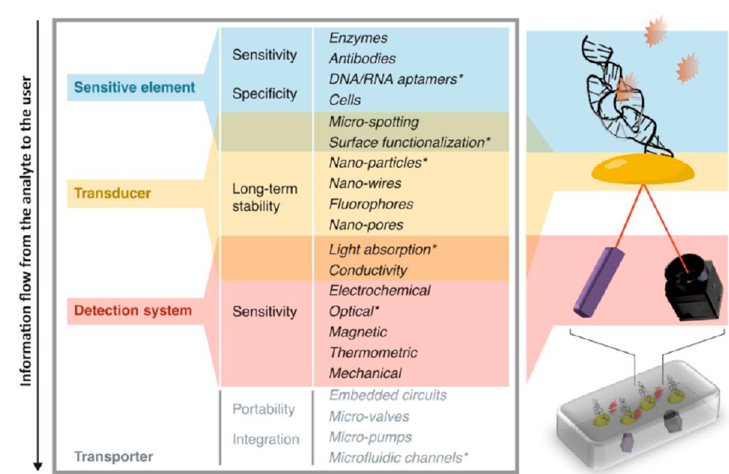
Figure 1. Migliozzi and Guibentif et al., looked at PoC bottlenecks from a technological standpoint. Figure re-used from [4] with permission under open-access creative commons copyright agreement.